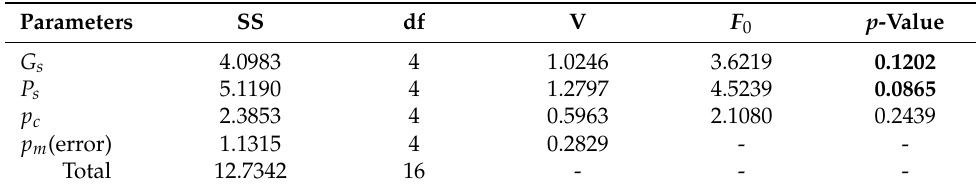
Figure 4. The mean S/N ratio and RDI plot for each GA parameter. ( a ) S/N ratio, ( b ) RDI. Table 4. ANOVA result for S/N ratio of GA